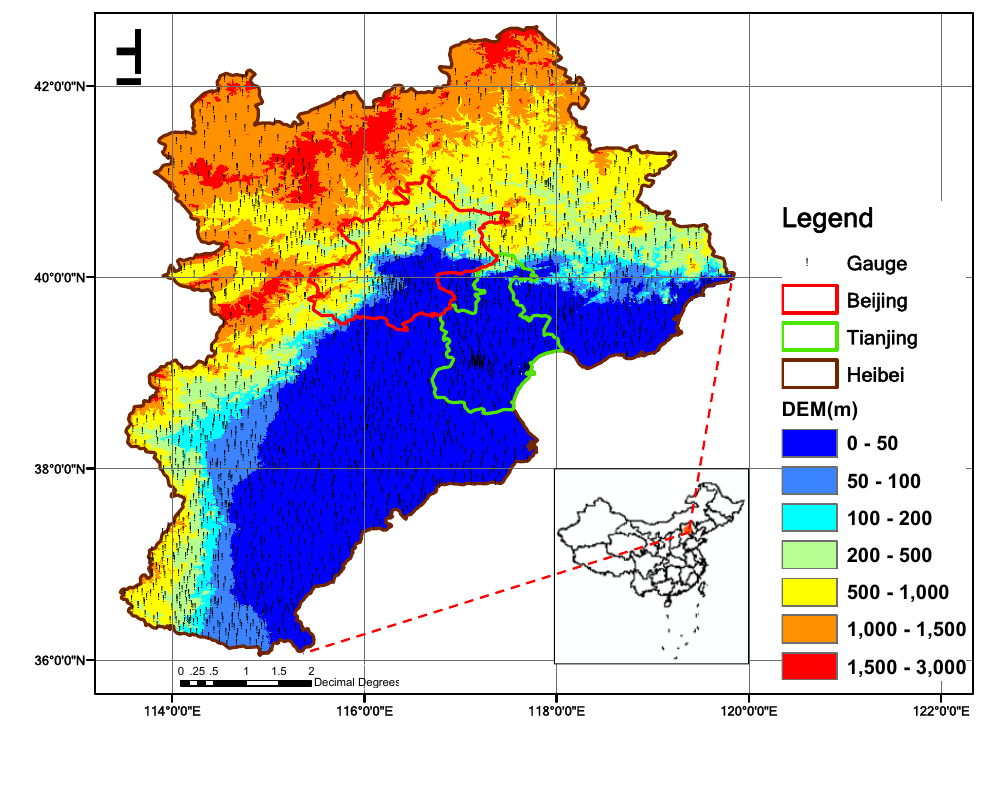
Figure 1. Study Region including Hebei province, Beijing city and Tianjin City